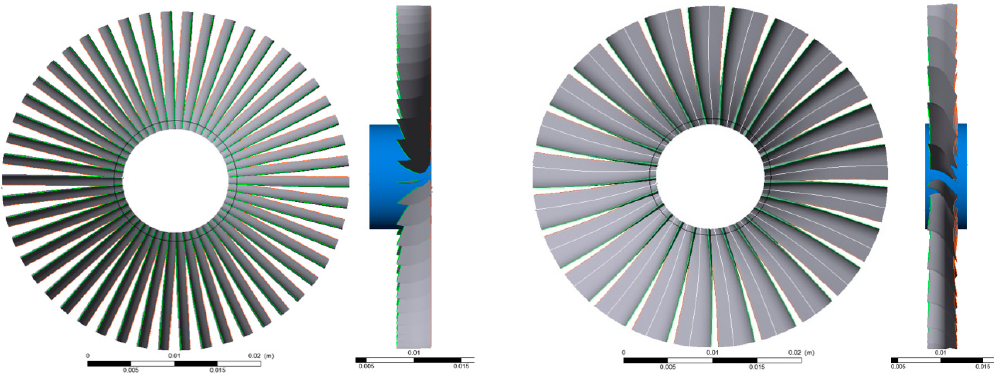
Figure 3. Front and side view of stator ( left ) and rotor ( right ) in TurboGrid.